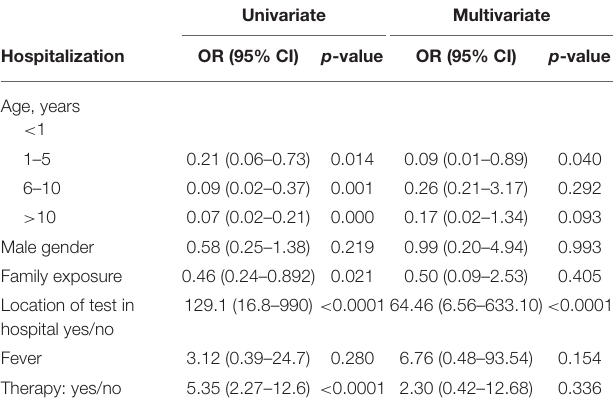
TABLE 2 | Characteristics of children who tested positive for severe acute respiratory syndrome coronavirus 2 (SARS-CoV-2) according to management setting in the Emilia-Romagna Region, Italy.